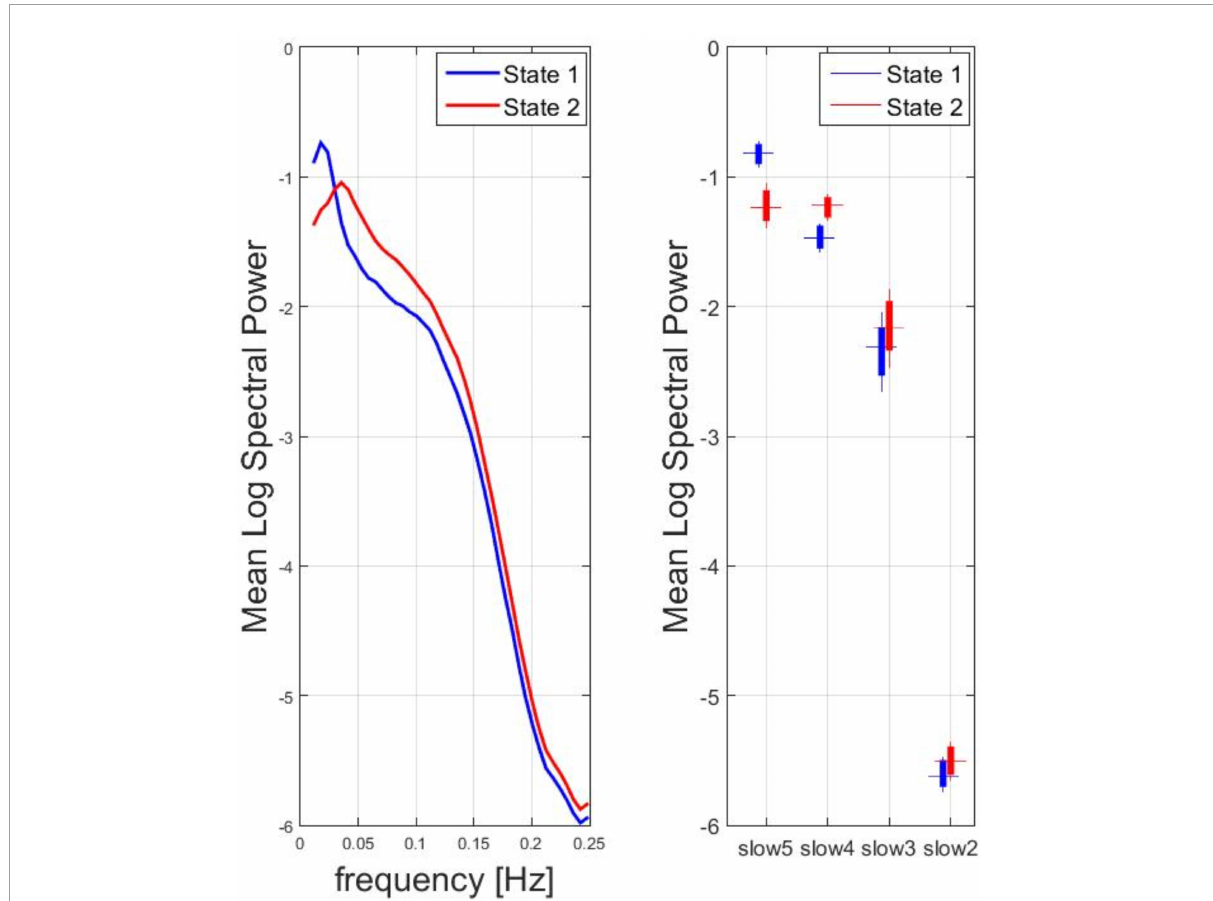
FIGURE2 Spectral analysis for two clusters of most recurrent dFC states: State 1, State 2. Left: for the two states, the mean logarithm of the spectral power (vs. frequency) in the range between 0.01 and 0.25 Hz was calculated. According to the peak frequency, state 1 was descriptively identified as a low-frequency dFC state, whereas state 2 was descriptively identified as a high-frequency dFC state. Right: Box plot of the mean log spectral power in the four canonical frequency bands across all